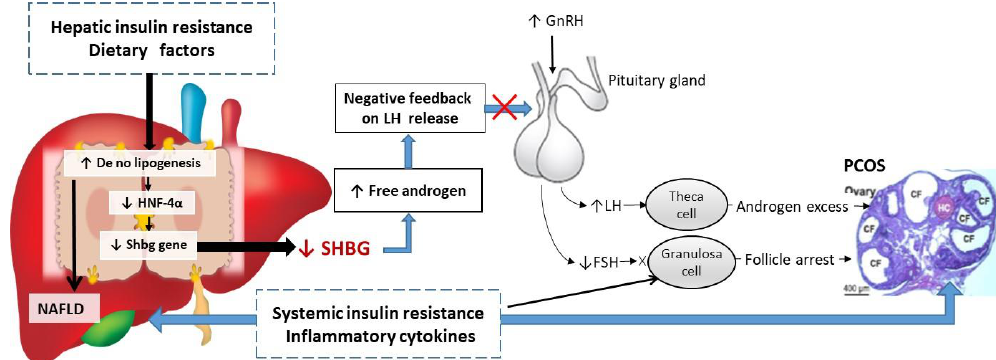
Figure 3. Schematic representation of the putative mechanisms linking low SHBG with the development NAFLD and PCOS. Increased hepatic de no lipogenesis inhibits SHBG synthesis through downregulating HNF-4 α , leading to increasing androgen bioavailability and disrupting negative feedback relationship of hypothalamic–pituitary–ovarian axis, subsequently resulting in higher levels of LH and lower levels of FSH in most women with PCOS. Higher LH levels seem to cause hyperandrogenemia by exuberating androgens secretion from follicular theca cells, whereas lower FSH levels lead to anovulation. System insulin resistance associated with inflammatory cytokines directly induces granulosa cells apoptosis, leading to arrested follicular maturation, contribute to anovulation and multiple cystic follicles (CF) formation in